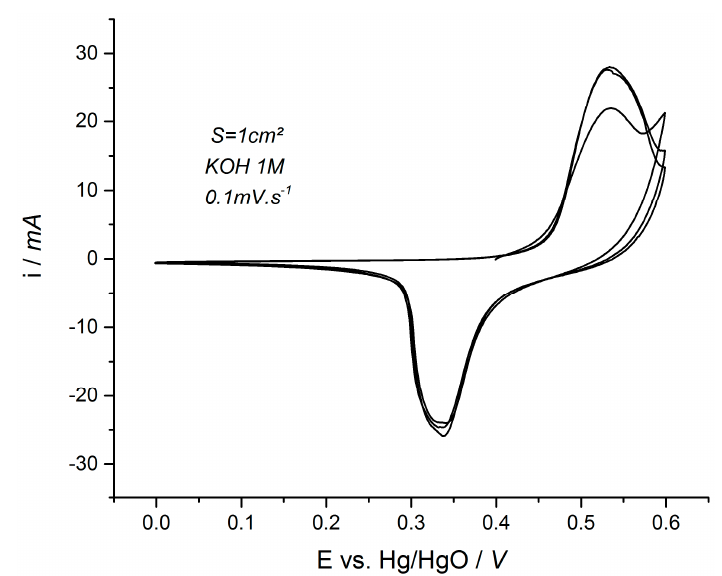
Figure 1. Typical representation of a cyclic voltammogram of a pure Ni(OH) 2 electrode at a scan rate of 0.1 mV·s − 1 in 1 M KOH electrolyte. Cycling was performed with a commercial Ni(OH) 2 electrode for the purpose of this